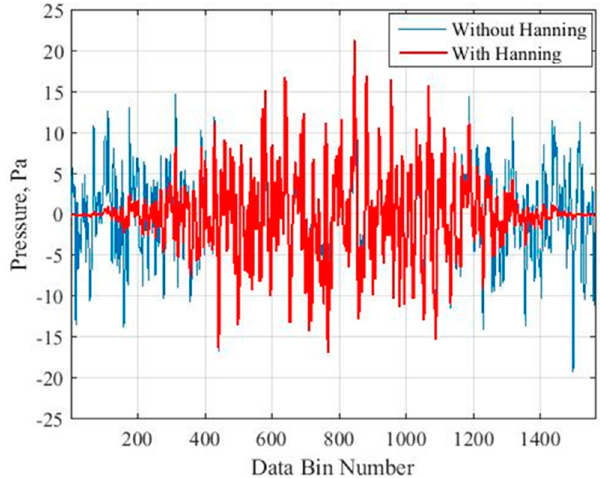
Figure 2. Typical broadband data segment with and without Hanning applied.